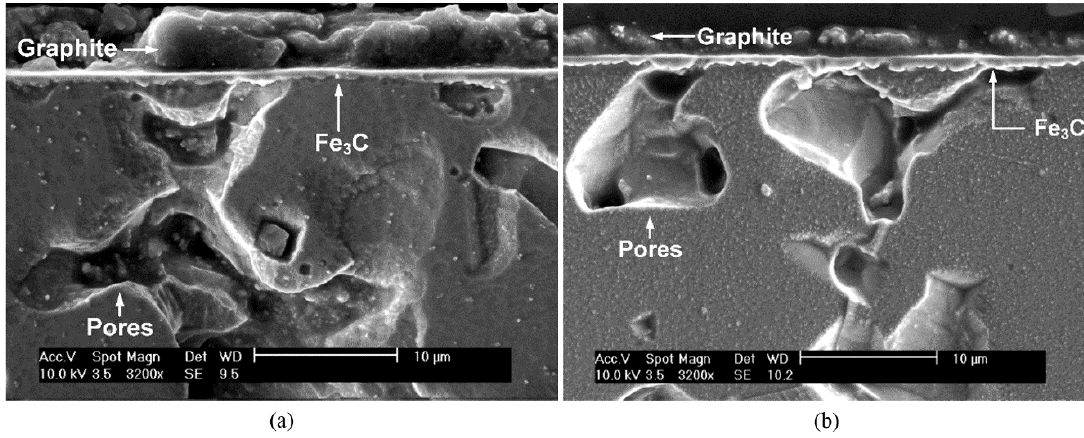
Figure 3. Cross-sectional micrographs of samples carburized at 500 °C for 3 hours: (a) 5% CH